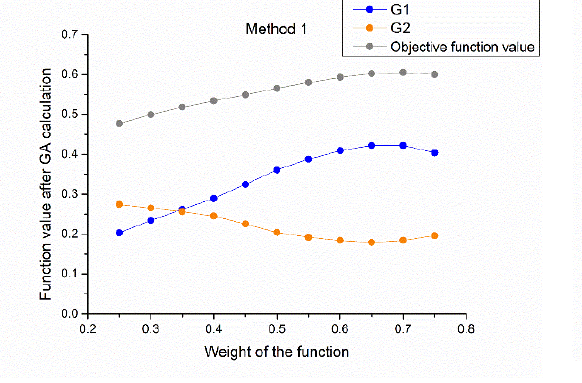
Figure 5. Multi-disciplinary objective function values based on ( a ) Method 1 and ( b ) Method 2.